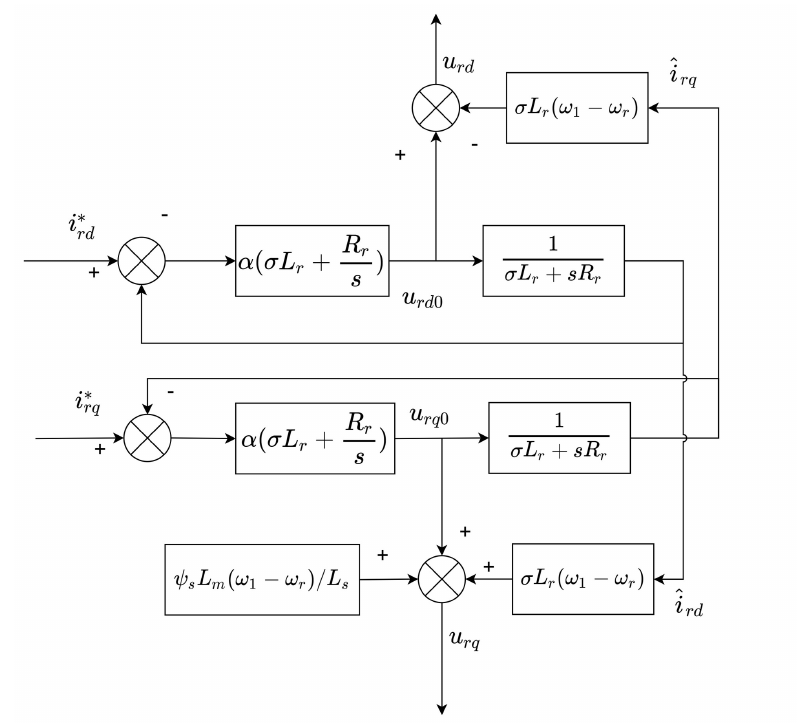
Figure 6. Description of the internal model open-loop